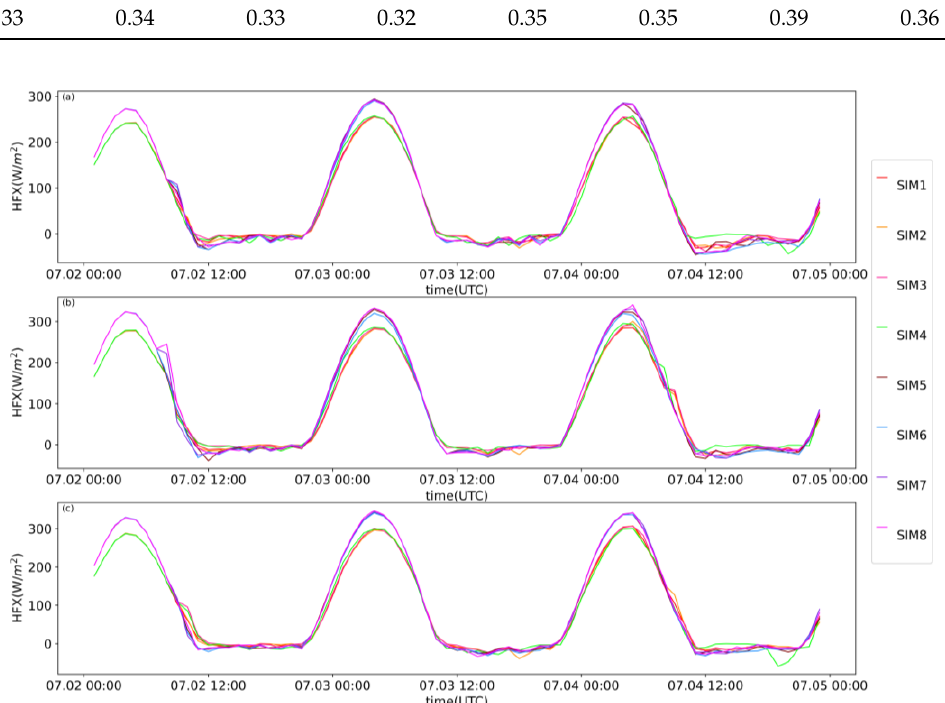
Figure 4. Time series of sensible heat fluxes simulated by eight combined schemes at ( a ) Rongcheng: 54,503, ( b ) Xiongxian: 54,636, and ( c ) Anxin: 54,605 . The correlation coefficients (R) of the temperature simulations (Table 2) in Rong- cheng, Xiongxian, and Anxin range from 0.91 to 0.98, and the overall correlation coeffi- cient (R) is greater than 0.93. A good positive correlation exists between the simulated temperature values and the observed values. SIM1-4 has a lower overall RMSE than SIM5- 8. The MM5 scheme is more accurate than the Eta scheme for simulating temperature. Figure 5 demonstrates that SIM7 has the poorest simulation, both when comparing the three regions independently and when comparing the three regions together. In addition to low simulation accuracy in Rongcheng, SIM4 performs best in Xiongxian, Anxin and overall. The BEP + BEM scheme provides a more detailed description of the process in the urban canopy, which reflects the influence of urban turbulence at different levels. Moreo- ver, indoor human activities and the influence of home equipment on the mixing of indoor and outside air would change the ambient temperature to some extent. The combination of the BEP + BEM and MM5 schemes provides the most accurate temperature simulation.